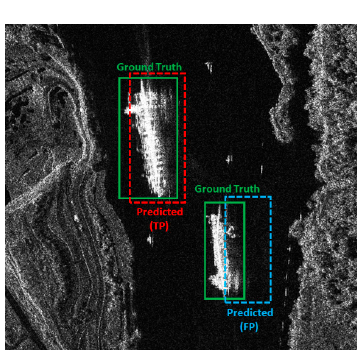
Figure 5. Example of calculate intersection over union (IOU) .